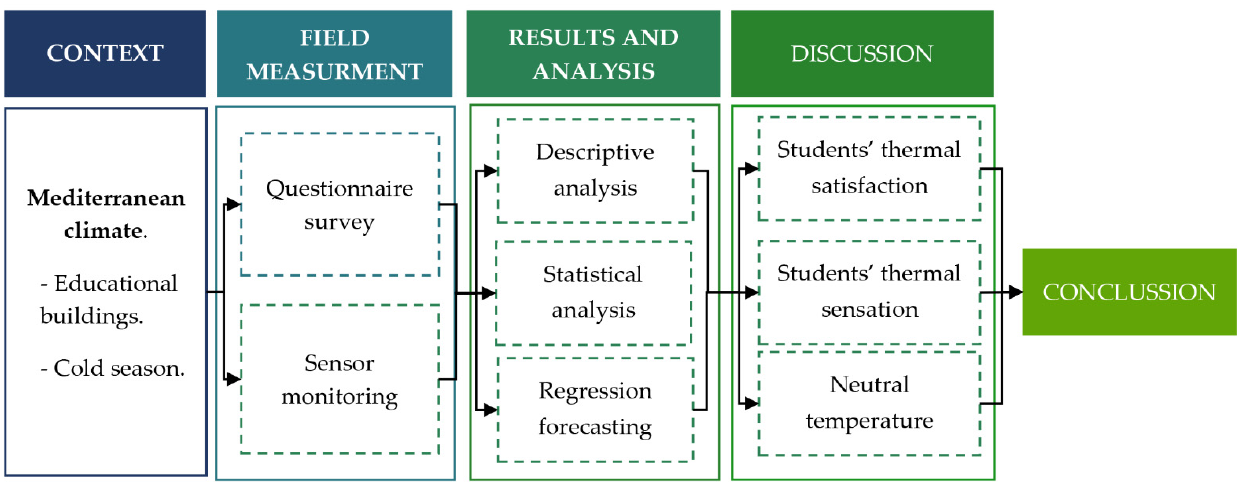
Figure 1. Methodological flow diagram.